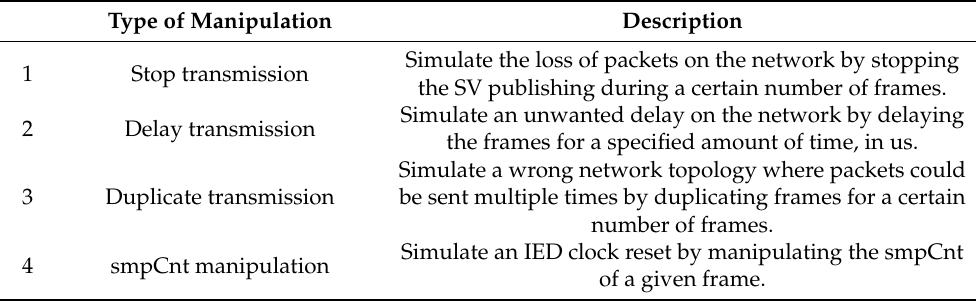
Table 1. Manipulations into the sampled value publisher